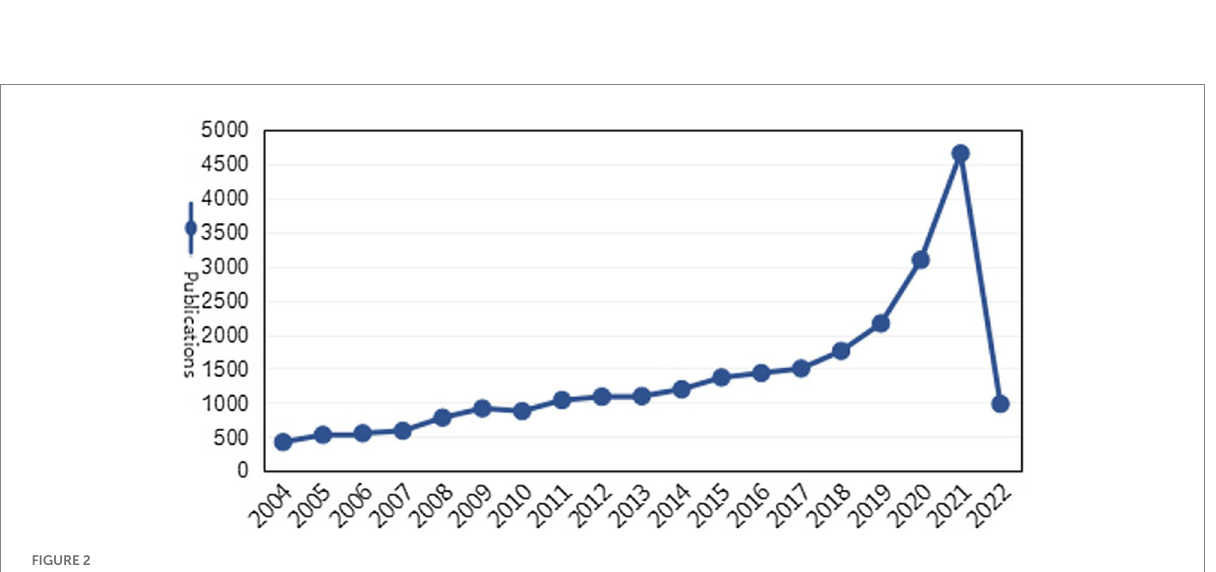
FIGURE 2 Publications from 2004 to